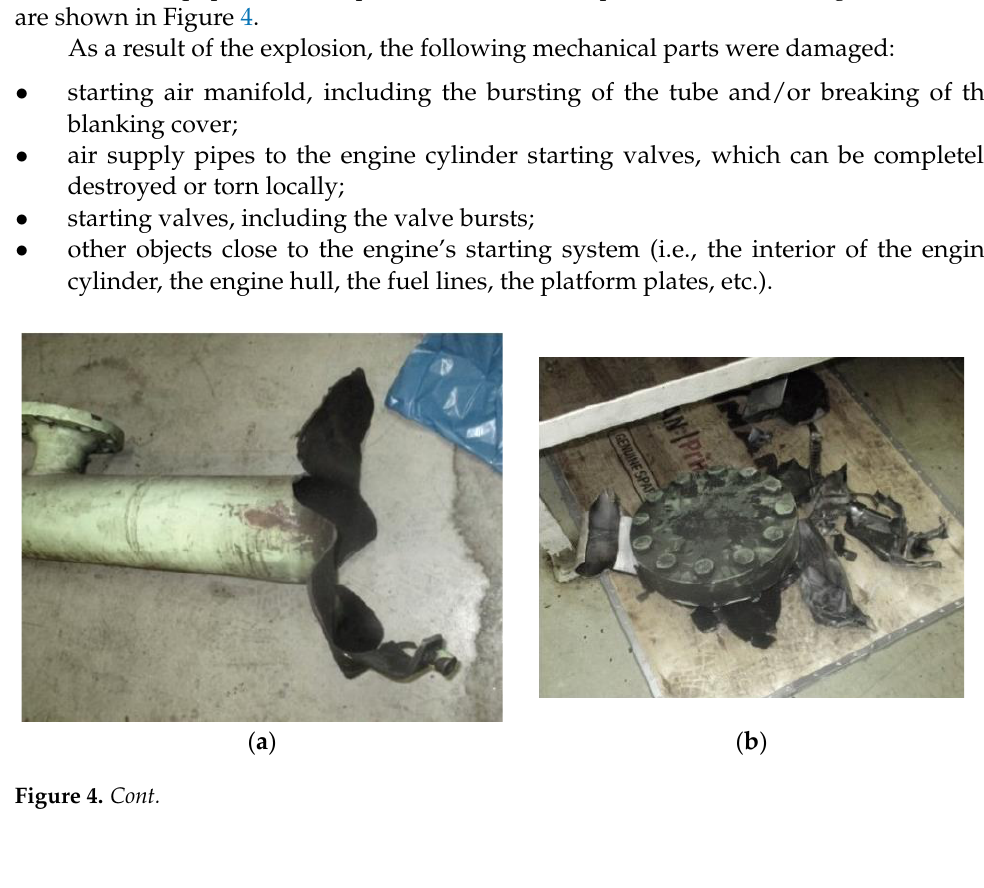
Figure 3. Photograph of the starting valve removed from the engine after an explosion in the starting air manifold (Royal Belgian Institute of Marine Engineers 2009).